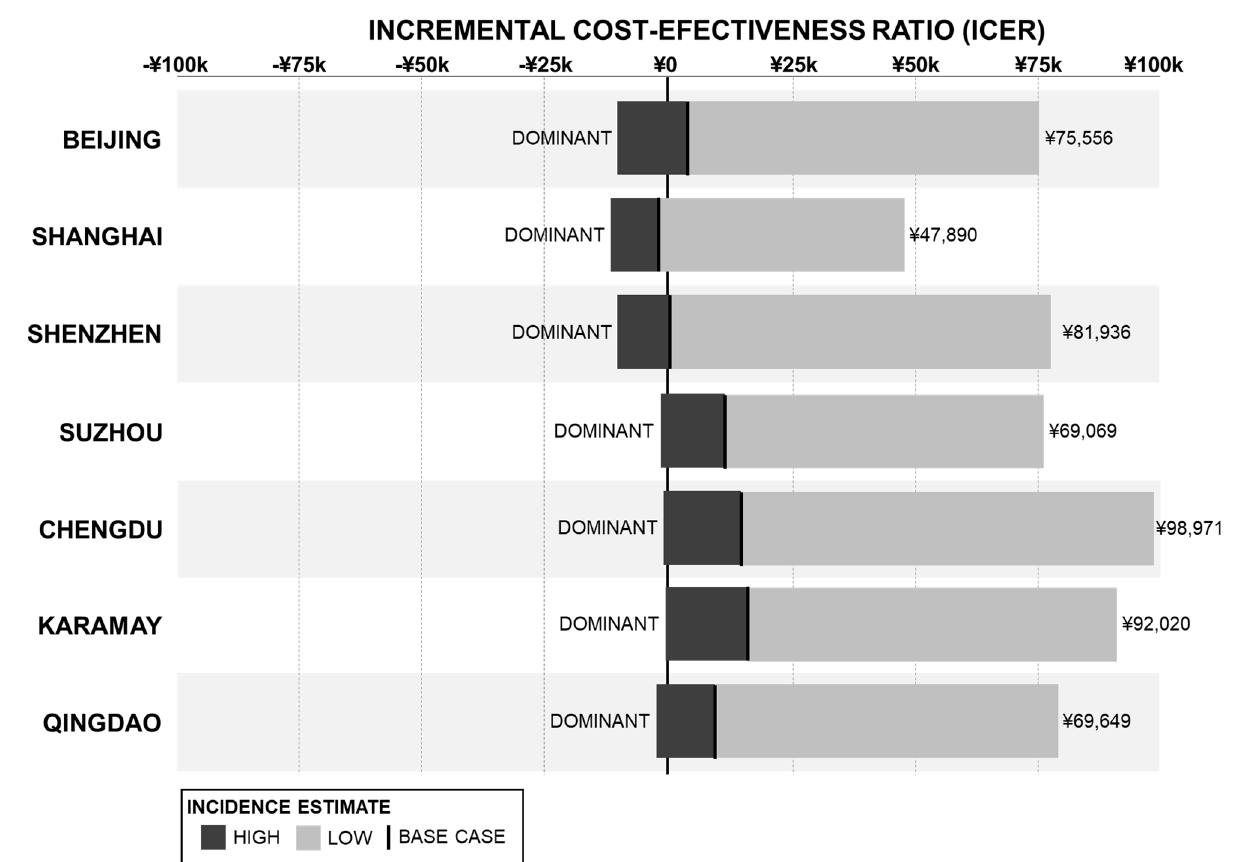
Figure 3. Scenario Analysis of Disease Incidence Rates—ICER Results. Table 5. DE-Only Scenario Results—Total Cases and Costs with and without the PCV13 Program. TIER-1 Cities Beijing